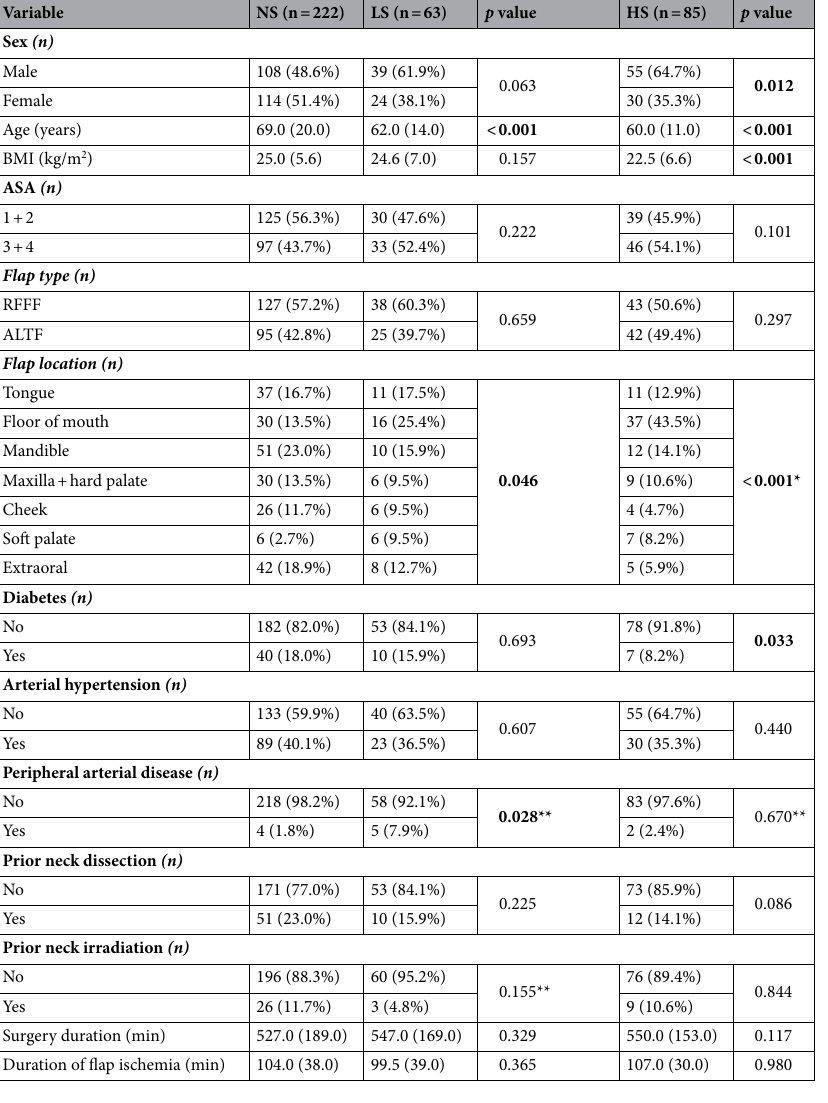
Table 1. Characteristics of the study population. Parameters are indicated as numbers (with percentage) for categorical data (sex, ASA, flap type, flap location, diabetes, arterial hypertension, peripheral arterial disease, prior neck dissection, prior neck irradiation) or median (with interquartile range) for metric data (age, BMI, surgery duration, duration of flap ischemia) (separately described for the group of nonsmokers (NS), the group of light smokers (LS) and the group of heavy smokers (HS)); p values corresponding to testing for differences between groups (NS vs. LS and NS vs. HS) with chi-squared test (sex, ASA, flap type, flap location (NS vs. LS), diabetes, arterial hypertension, prior neck dissection, prior neck irradiation (NS vs. HS)), Freeman Halton test (*) (flap location (NS vs. HS)), Fisher’s exact test (**) (peripheral arterial disease, prior neck irradiation (NS vs. LS)) or Mann Whitney Test (age, BMI, surgery duration, duration of flap ischemia); significant p values are bold; NS nonsmokers, LH light smokers, HS heavy smokers, BMI body mass index, ASA American Society of Anesthesiologists score, RFFF radial free forearm flap, ALTF anterolateral thigh